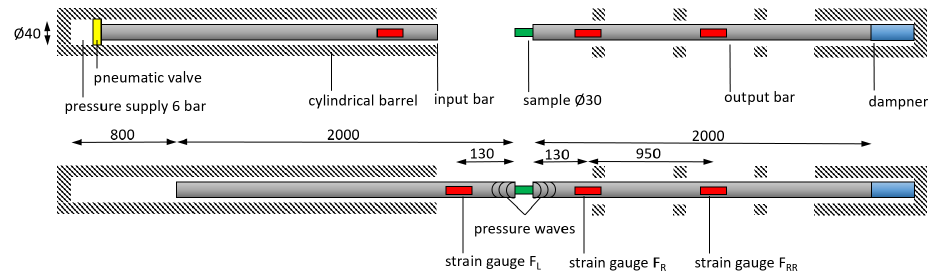
Figure 2: Sketch of Symmpact: a direct impact hopkinson bar used in this work. All dimen- sions are in mm.